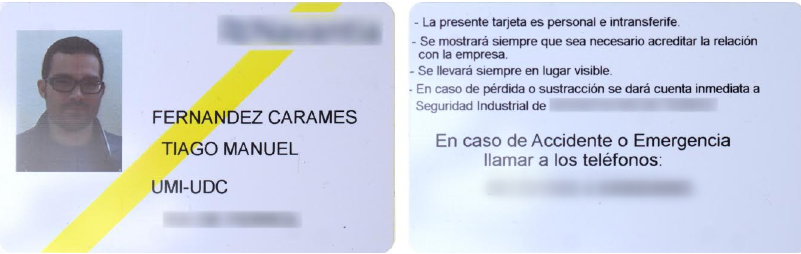
Figure 14. HID proximity card.